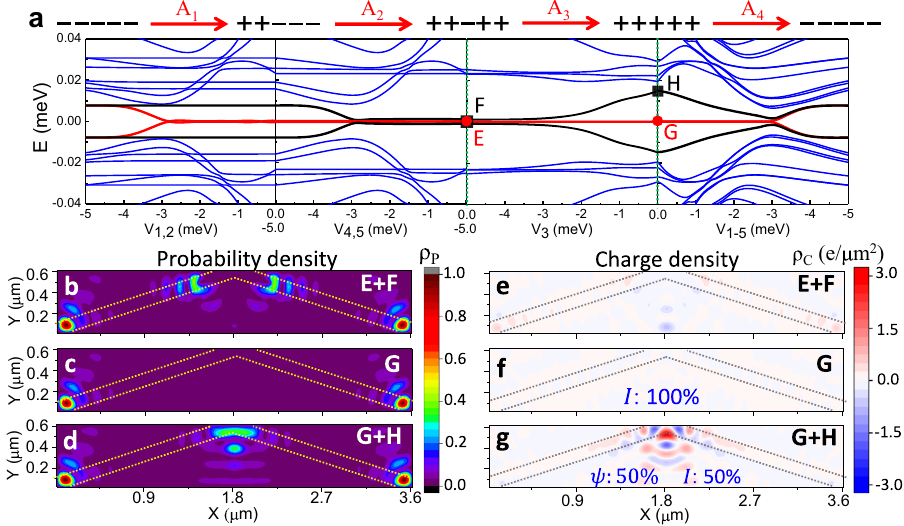
Fig. 7 Outcome of the MBS fusion in a VJ. a Spectrum evolution for the operations A 1 – A 4 as a function of the relevant mini-gate voltage. Red and black lines: evolution of fi nite-energy states into MBS inside the topological gap. E and F: the two MBS pairs (degenerate ground states) in the + + − + + con fi guration (before fusion). G and H: the ground and fi rst excited states in the + + + + + con fi guration (after fusion). b Sum of the probability densities, ρ ρ ρ – g The same as b – d , but for charge densities, ρ N regions covered by P for E and F. c P for G. d sum of the P for G and H. e C . The dashed lines mark the the mini gates. ρ P is normalized to its maximum. The (minimum, maximum) values in e – g are ( − 0.7, 0.5), ( − 0.02, 0.03), and ( − 1.9, 3.0), respectively. The parameters are taken from Fig.